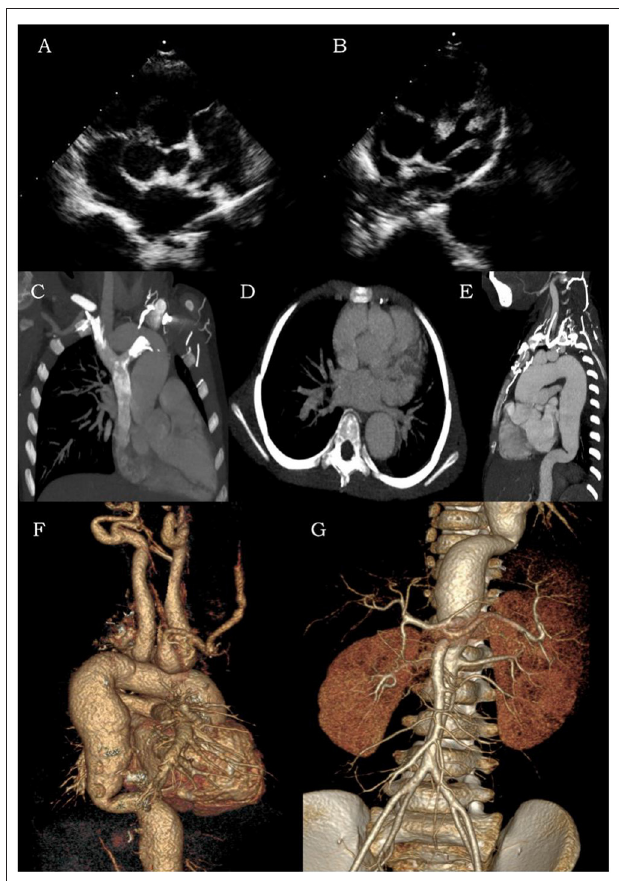
FIGURE 1 | Transthoracic echocardiography (A,B) and computed tomographic angiogram (C–G) of coronary arteries, aorta, and its major branches. The contrast CT and color ultrasound showed multiple areas of arterial dilation in the aorta, coronary artery, bilateral carotid arteries, subclavian artery, brachiocephalic artery, innominate artery, and bilateral axillary arteries as well as compressed and narrowed jugular and left brachiocephalic veins with backflow